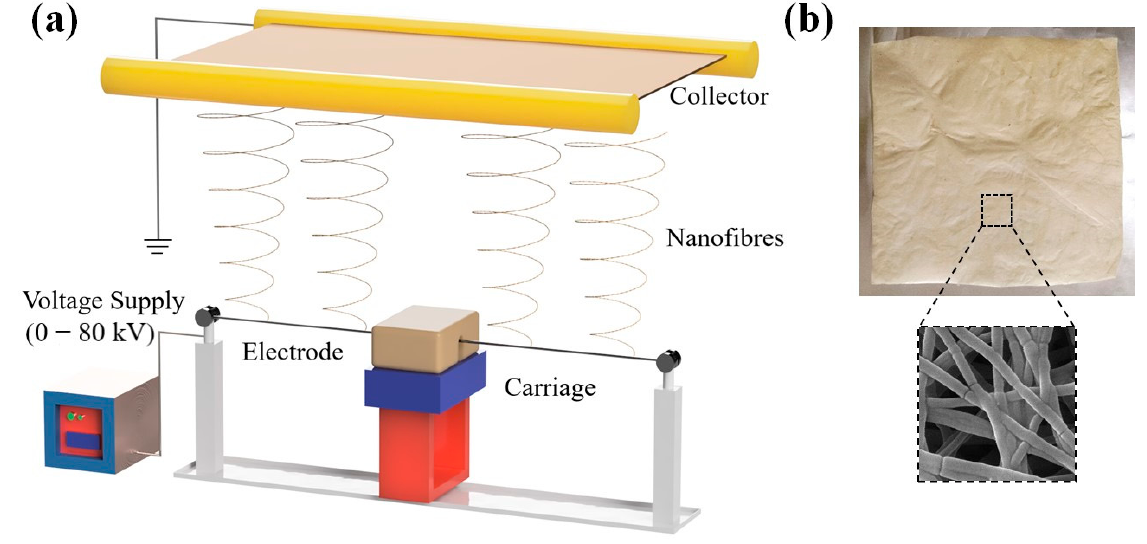
Figure 2. ( a ) Schematic illustration of the needless electrospinning process and ( b ) Photograph and SEM image of a PEO/GE nanomembrane .